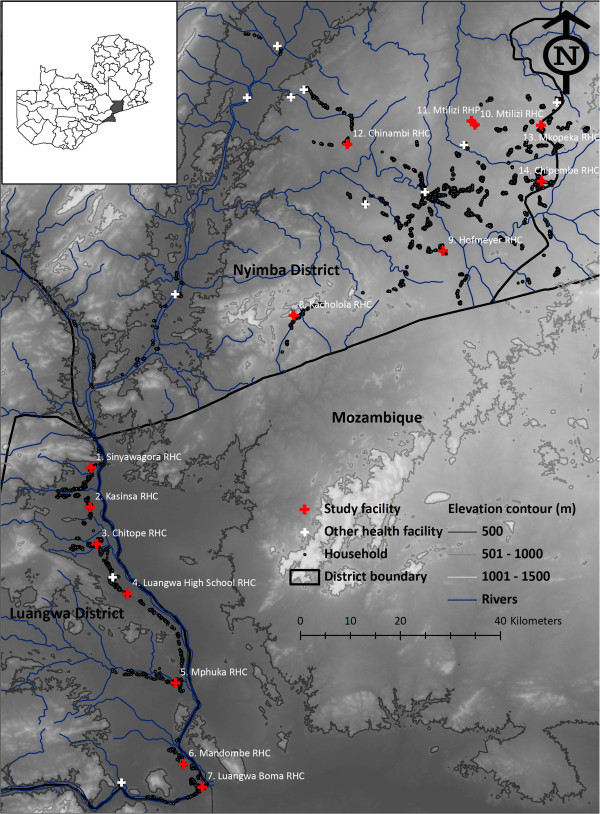
Location of study site, and numbered survey clusters around health facilities, in Zambia.